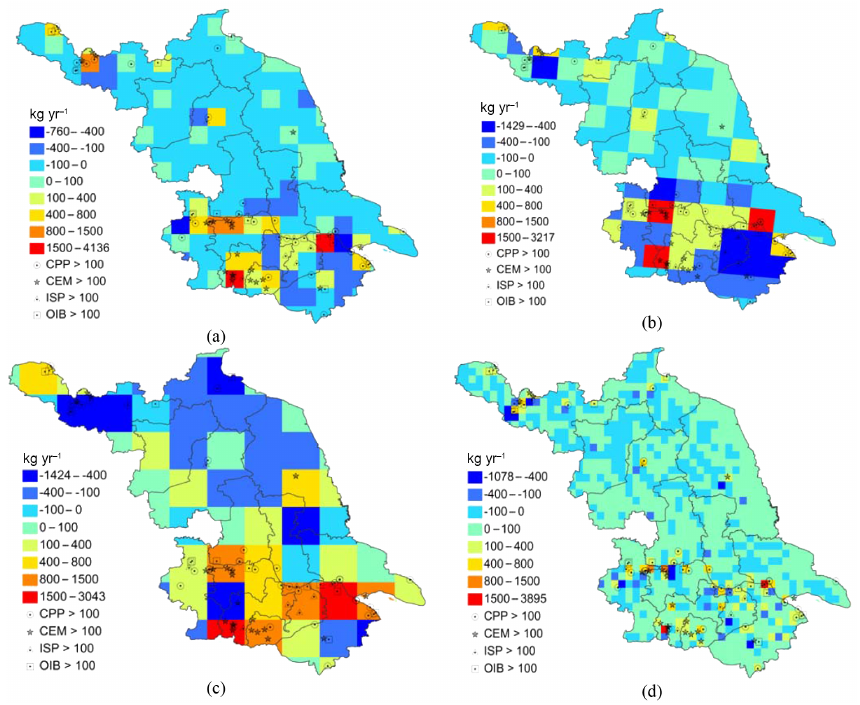
Figure 4. Differences in gridded Hg T emissions in Jiangsu 2010 between provincial and other inventories: emissions in the provincial inventory minus those in NJU (a) , THU (b) , AMAP/UNEP (c) , and EDGARv4.tox2 (d) . The locations of point sources with relatively large Hg emissions estimated in the provincial inventory are indicated in the panels as